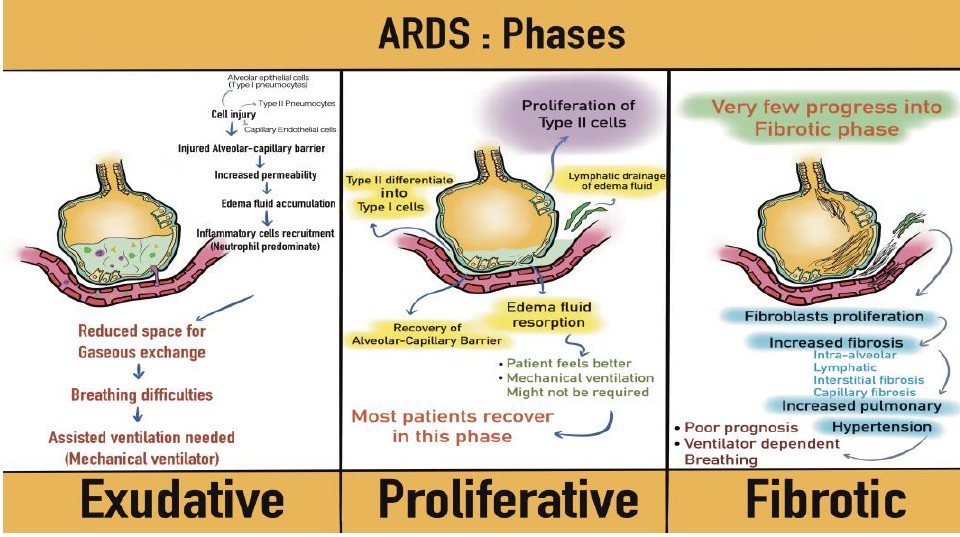
Figure 1. The progression of histopathological findings in acute respiratory distress syndrome